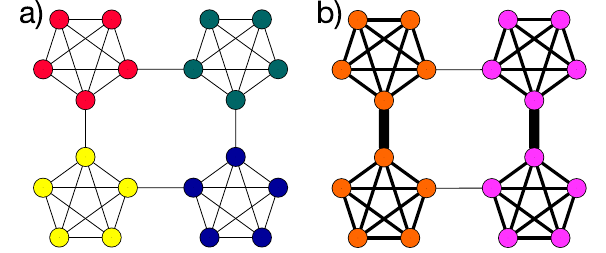
Fig. 3 Comparison between the ‘ ring of binary cliques ’ and the ‘ ring of weighted cliques ’ cases. Panel a depicts the four communities detected by surprise on a ring of binary cliques. As panel b shows, the result according to which surprise minimization is able to discriminate the cliques linked in a ring-like fashion changes once the weights come into play: in fact, as the weight of the links connecting any two cliques is risen, the algorithm reveals pairs of tightly-connected cliques as